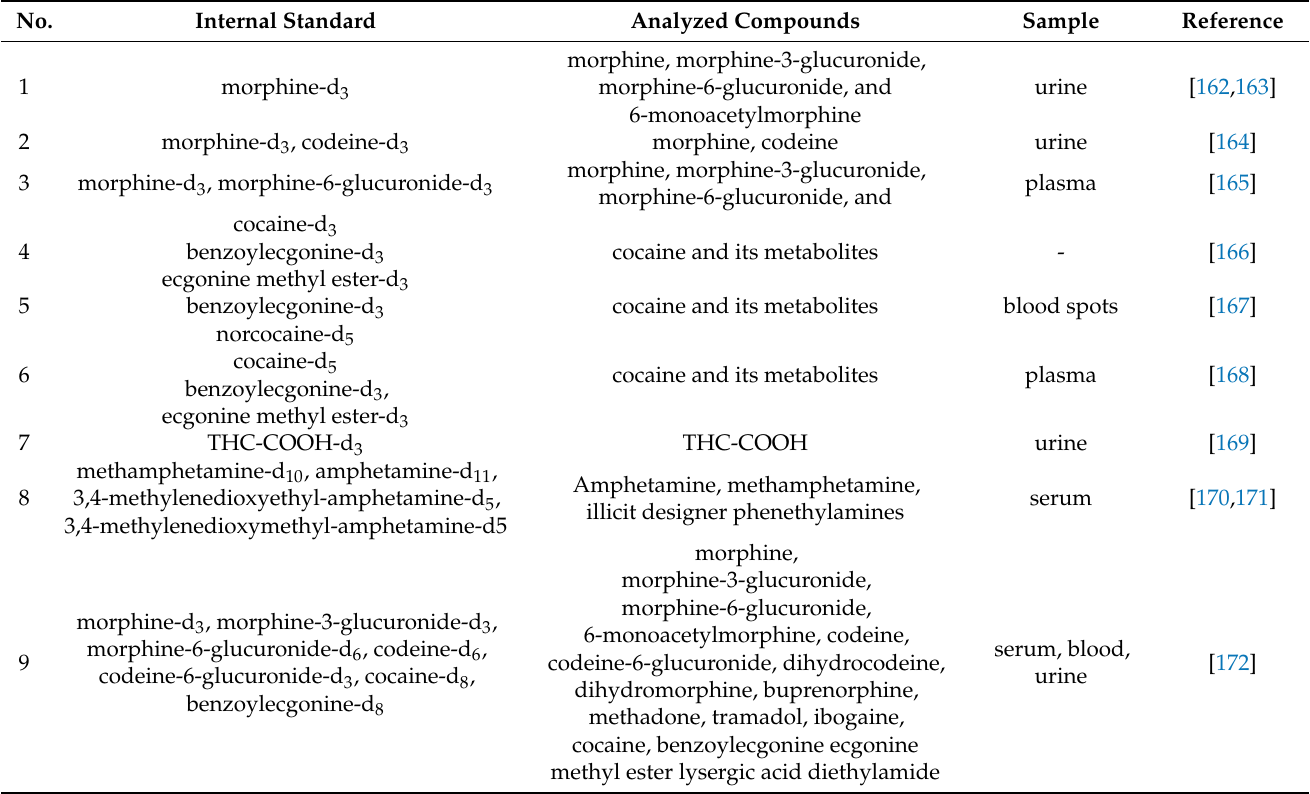
Table 5. Selected examples of deuterated internal standards used in forensic toxicology for quantita- tive LC-MS analysis of various